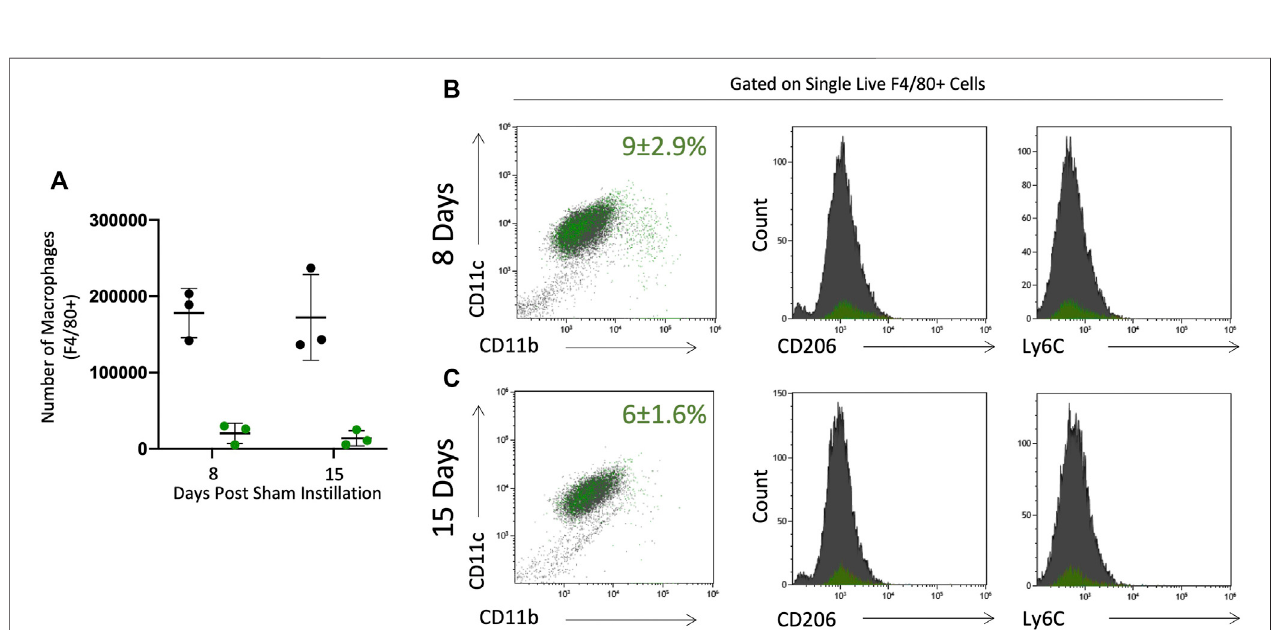
FIGURE2| BALmacrophagescollectedfromshaminstilledGFPchimericmiceareconsistentwithresidentalveolarmacrophages.Pulmonarymacrophageswere collected by bronchoalveolarlavage in GFP chimeric mice 8 and 15 days post sham intratracheal instillation. Origin wasdetermined by GFP expression to identify tissue resident (black) and monocyte originated (green) macrophages. Tissue resident (black) and monocyte originated (green) macrophages were quanti fi ed as absolute number (A) . Percent (± SE) of total F4/80 + single live cells that are monocyte originated (green dots) is given in CD11c vs. CD11b plots in panels B&C. Maturity (CD11c and CD11b expression) and phenotype (CD206 and Ly6C) were assessed by fl ow cytometry at 8 (B) and 15 (C) days post sham instillation. Tissue residency (black) or monocyte origination (green) did not alter maturity or activation marker expression.